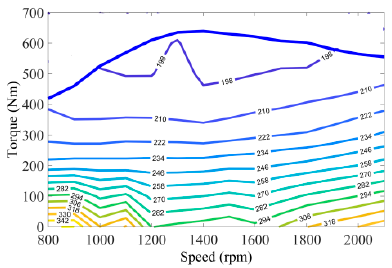
Figure 2. The BSFC map of the